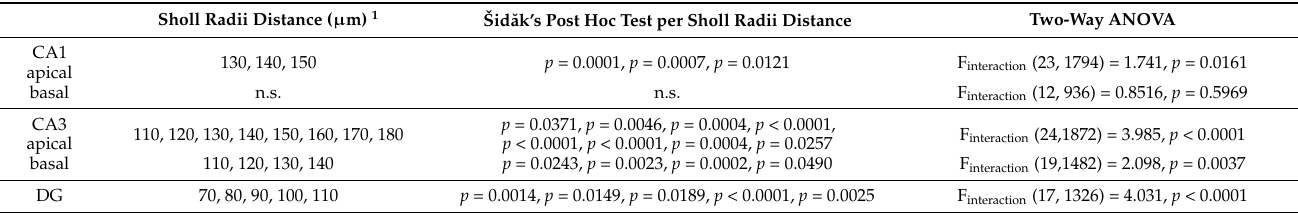
Table 1. Results of two-way ANOVA tests for the effects of the genotype and distance on dendritic arborization (mean no. of crossing dendrites) in each hippocampal subregion of WT and KO mice measured by Sholl analysis ( n = 40 neurons/group). Sholl Radii Distance ( µ m) 1